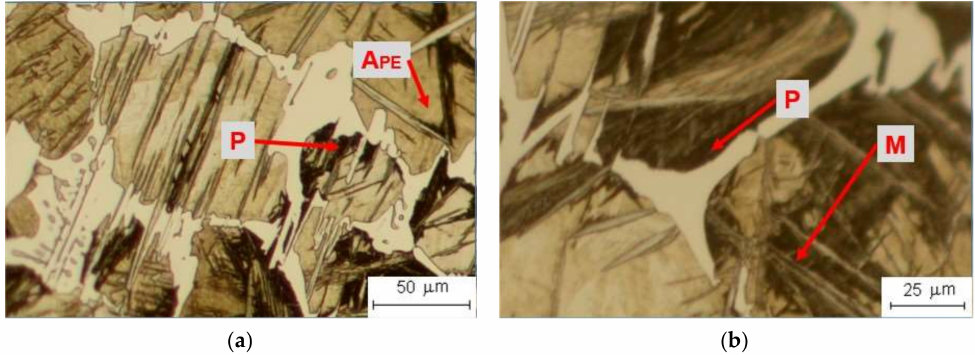
Figure 9. Nital-3 at room temperature: ( a ) general view at 200 × ; ( b ) detail at 500 × .